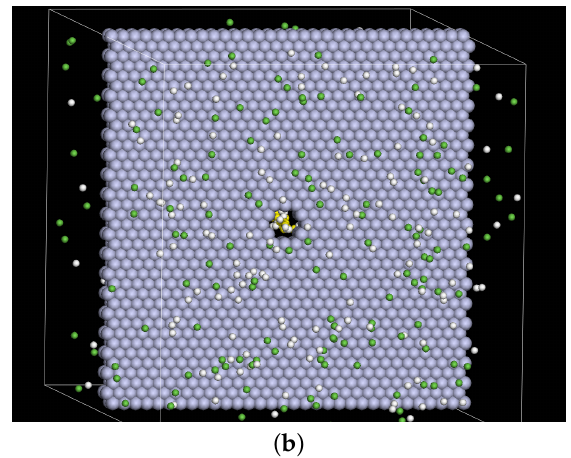
Figure 1. ( a ) Snapshot of a system of N = 128, where N refers to the number of monomers; ( b ) the membrane wall viewed from the trans side of the system. A pore is punched through the wall at the center. The gray beads represent the wall. The yellow, white, and green beads represent the monomers, cations, and anions,